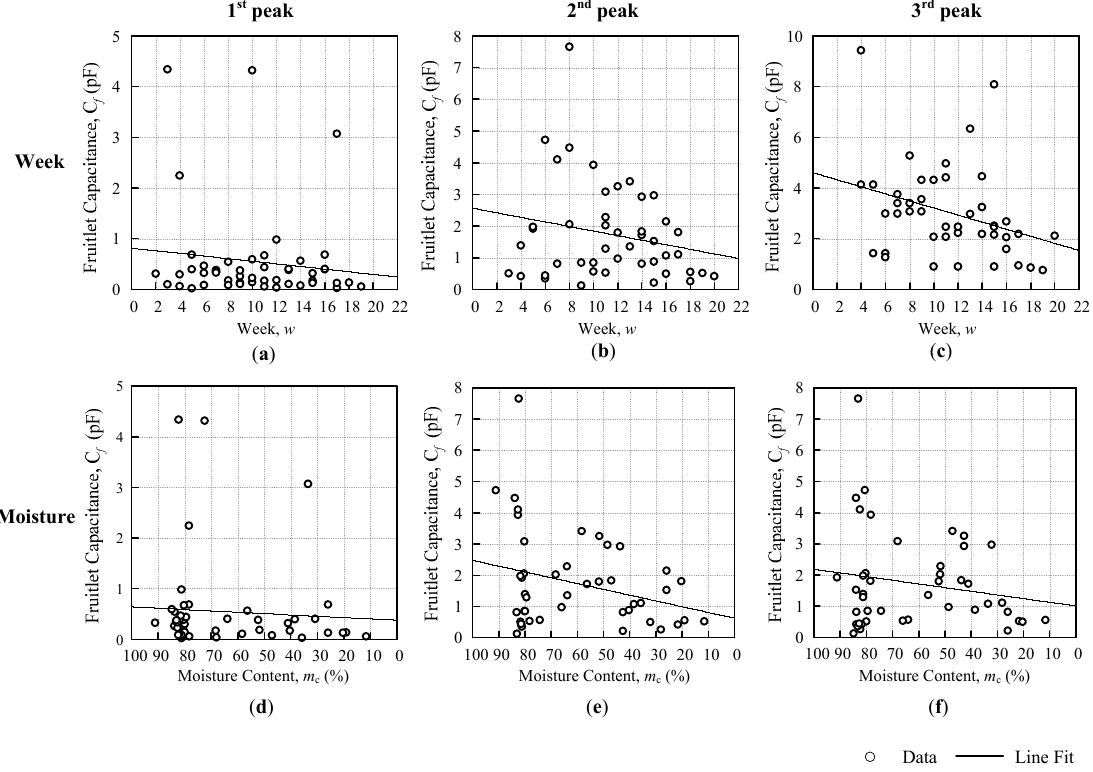
Figure 14. Triple I first, second, and third fruitlet capacitance against the weeks ( a – c ) and moisture content ( d – f ).